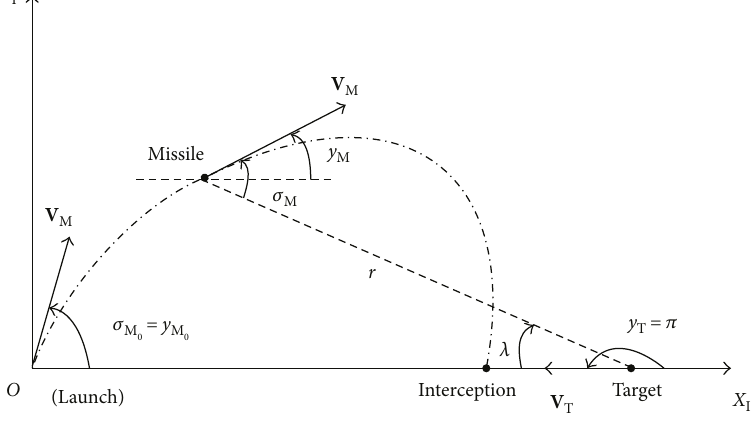
Figure 1: Engagement